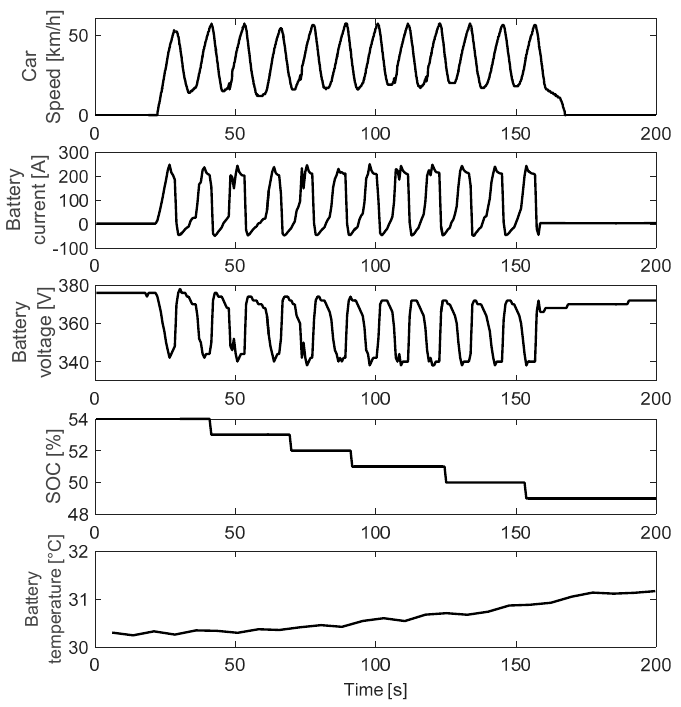
Figure B2. The measured data of the rapid acceleration and deceleration drive test.